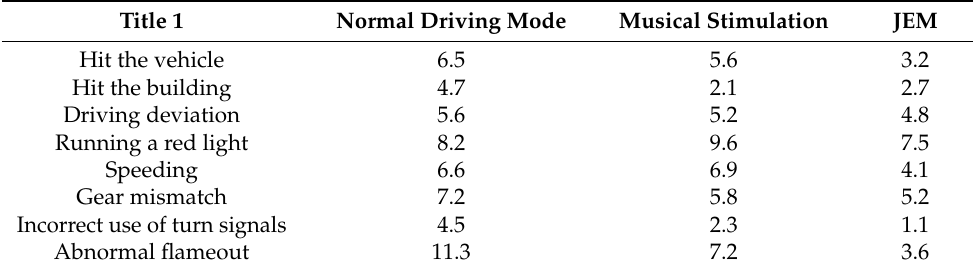
Table 1. The average value of the subjects’ wrong driving operations in the